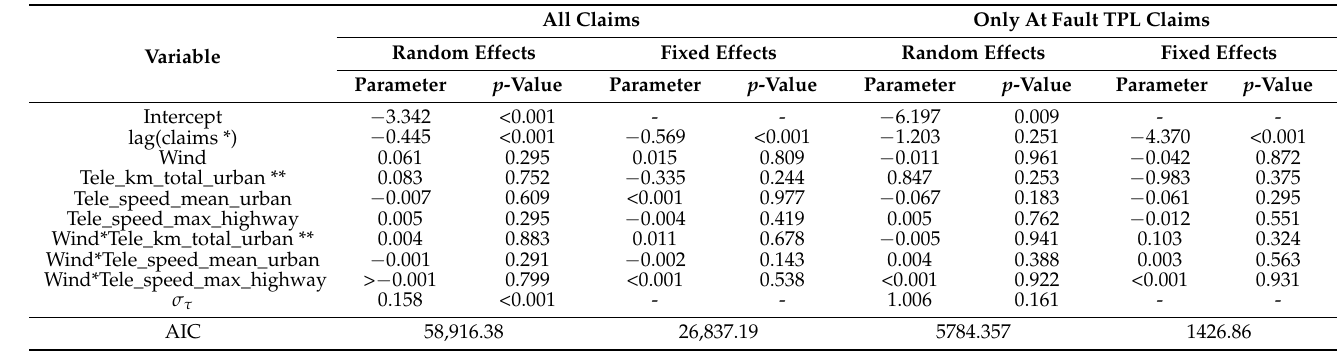
Table A10. Cross-table with the parameter estimates of random effects and fixed-effects Poisson panel data models, with p -values. for the total number of claims (left) and at-fault third party liability (TPL) claims (right) per month and per insured based on the seven observed months in 2018 and 2019. Interactions are